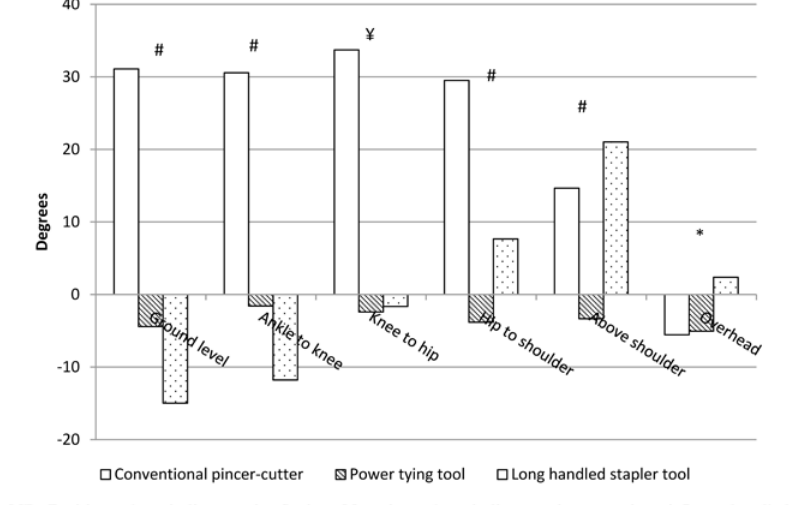
Peak right wrist flexion/extension by tool and work height Analysis of post hoc test data revealed that peak flexion/extension scores for the right wrist differed significantly between the pincer-cutter tool and both of the alternative tools at all work heights except when working directly overhead (p < 0.05). When working